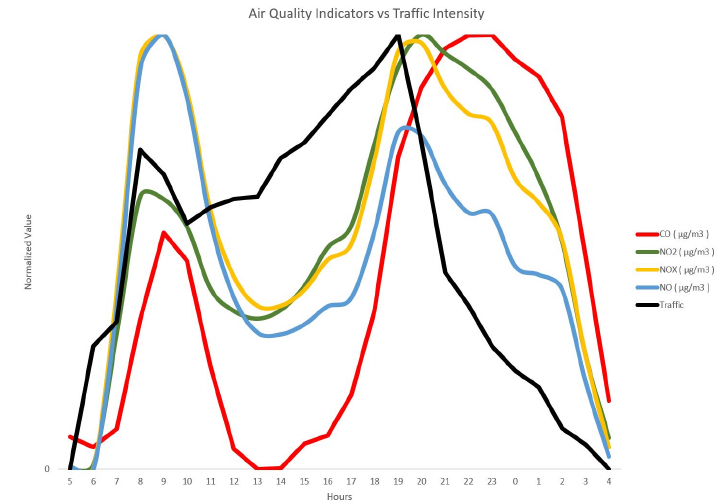
Figure 3. Normalized air quality indicators and traffic